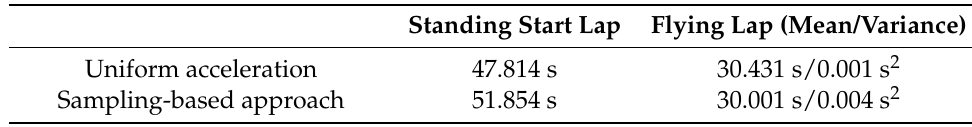
Table 1. Lap time comparison for single-vehicle driving on the LVMS.